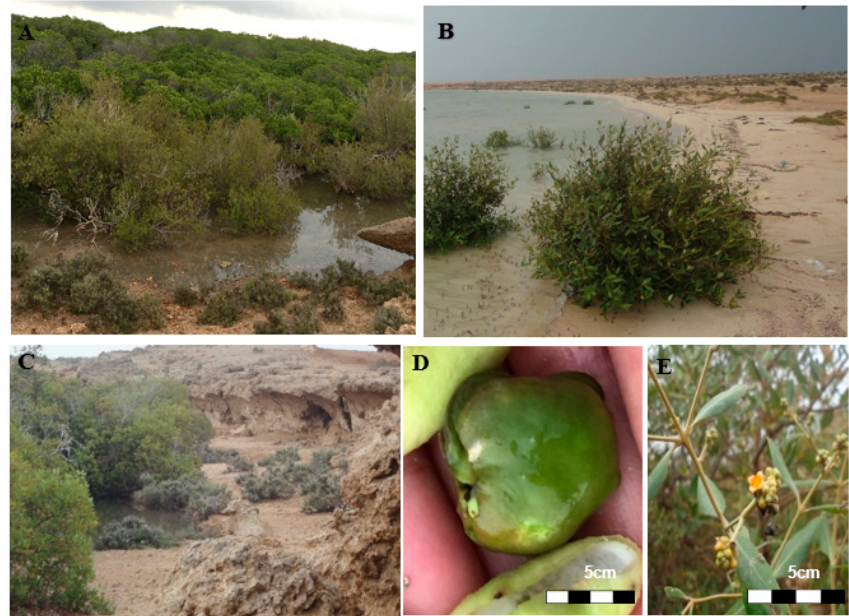
Figure 2. Different habitats of A. marina in the Farasan archipelago. ( A ) coral sand on Farasan Alkabir Island, ( B ) sand on Sajid Island, ( C ) rocky habitat on Farasan Alkabir Island, ( D ) propagule of A. marina, and ( E ) the flower of A. marina .